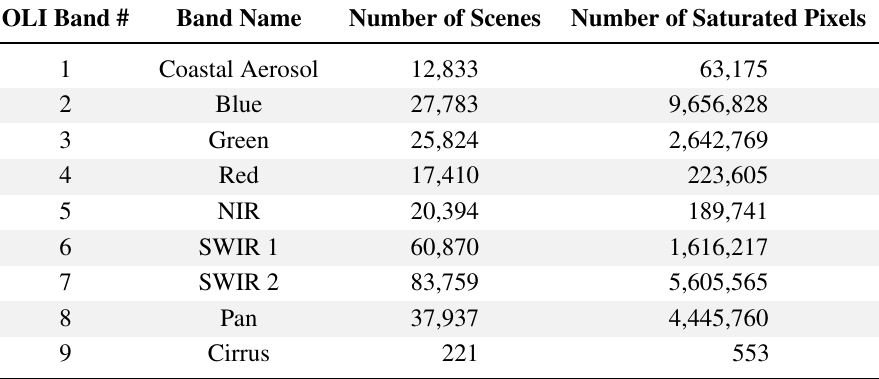
Table 6. Number of scenes containing saturated pixels out of 222,897 and the total number of saturated pixels in those